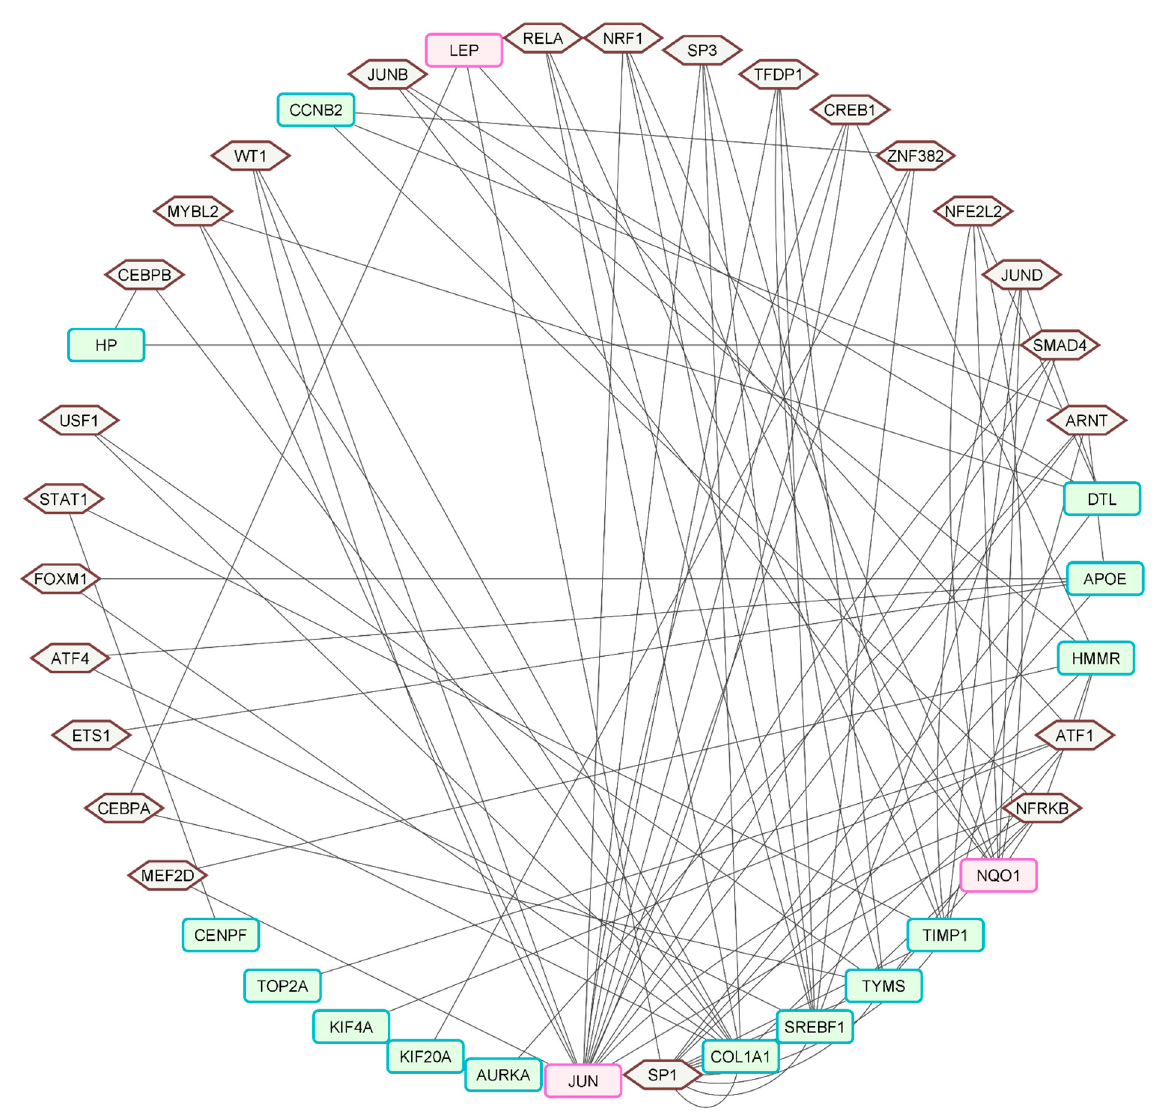
Figure 6. The hub gene-transcription factor (TF) network. The hexagons with brown outlines indicate the TFs, and the round, rectangular nodes are the hub genes, those upregulated marked with the red-purple border and those downregulated with the green border. The network had 17 hub genes and 24 TFs, with 90 hub gene–TF interaction pairs.